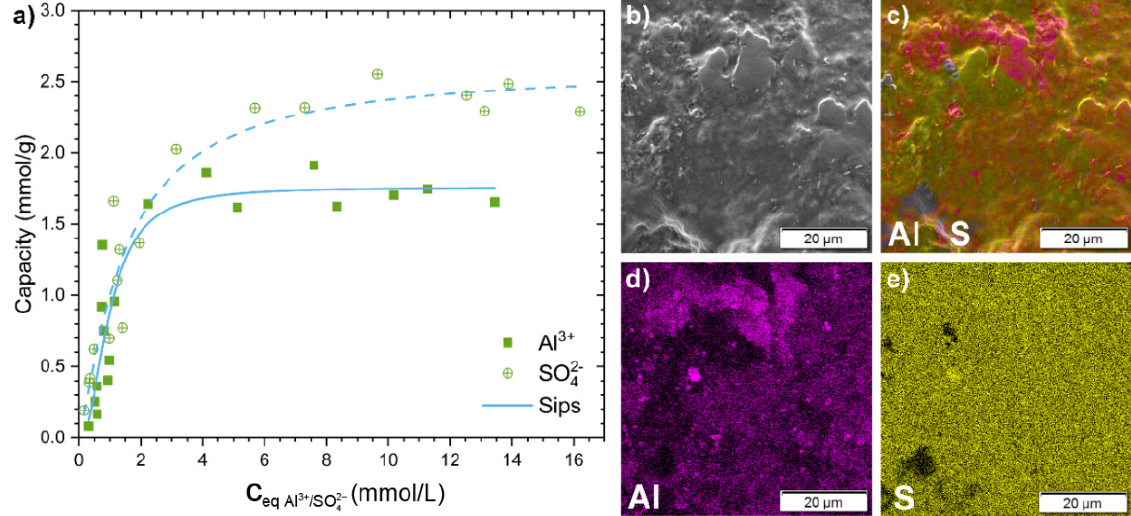
Figure 5. ( a ) Adsorption capacity for Al 3+ (filled squares) and SO 42 − (crossed circles) from Al 2 (SO 4 ) 3 solutions at the respective equilibrium concentrations c eq with the corresponding Sips isotherm model fits (blue, solid line for Al 3+ and dashed line for SO 42 − ). The corresponding pH values for the experiments can be seen at Figure S16. ( b – e ) SEM-EDX image and mapping of H-Ch60-2 after the adsorption experiment with Al 2 (SO 4 ) 3 solution (c 0 = 370 mg/L Al 3+ ). ( b ) SEM image of H-Ch60-2 after the adsorption with Al 2 (SO 4 ) 3(aq) ; ( c – e ) SEM-EDX elemental mapping of ( c ) Al (purple) and S (yellow), ( d ) Al (purple), and ( e ) S (yellow). The corresponding EDX spectra are shown in Figure S18. The SEM-EDX and SEM images for H-Ch60-2 before the adsorption process are shown in Figure S8. From the chosen models, the adsorption process—both of Al 3+ and SO 42 − ions—can be best described with Sips isotherm equation (see R 2 and fitting parameters in Table